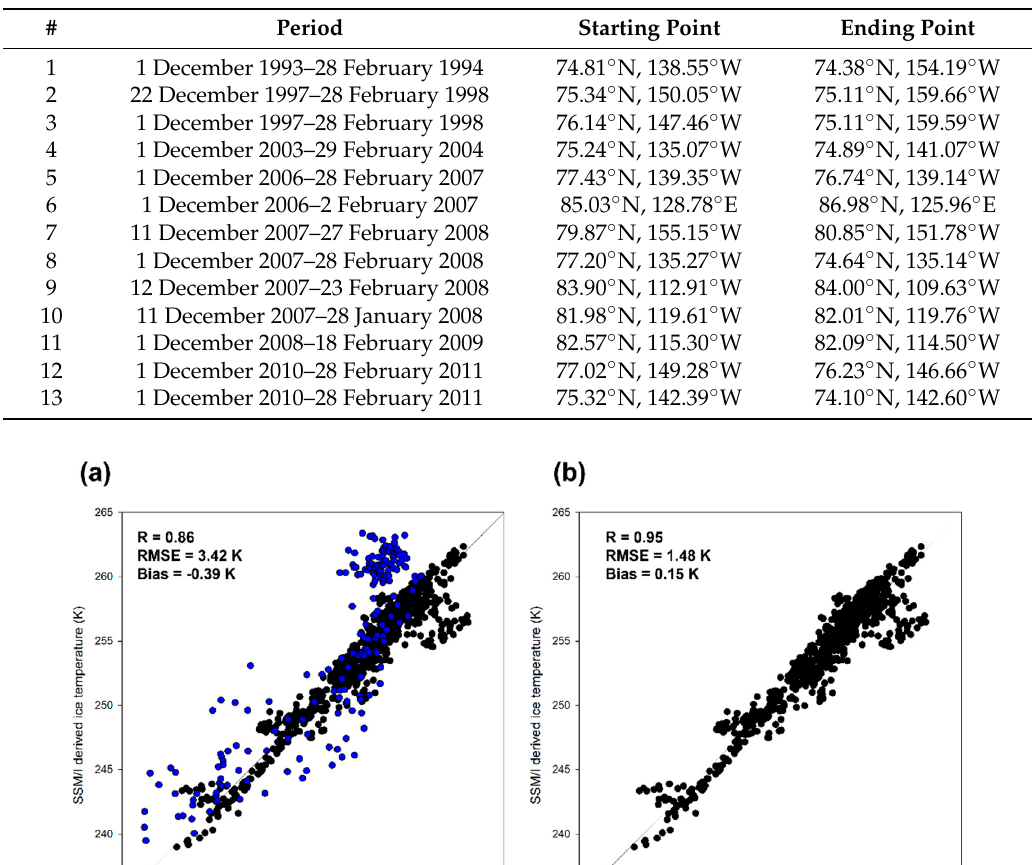
Table 3. Used data periods and starting/ending points of buoys used for validation.